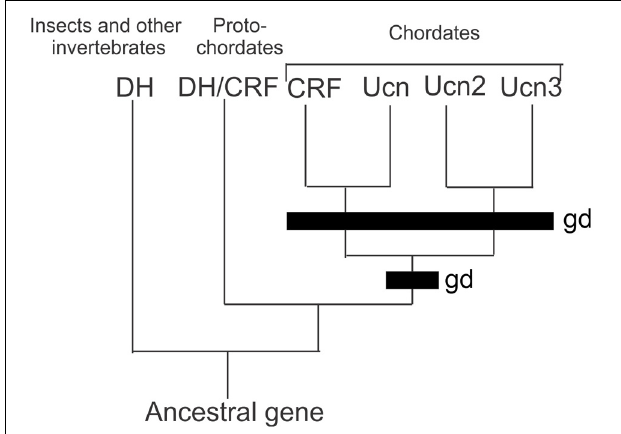
FIGURE 1 | Comparison of the CRF peptides family in chordates by genome duplication. Two rounds of genome duplications early in chordate ancestry gave rise to the four paralogous CRF related peptides. Abbreviations: DH, diuretic hormone; DH/CRF, diuretic hormone/corticotrophin releasing factor like peptide; CRF, corticotrophin releasing factor; UCN, urocortin; UCN2, urocortin 2; UCN3 urocortin 3; gd, genome duplication